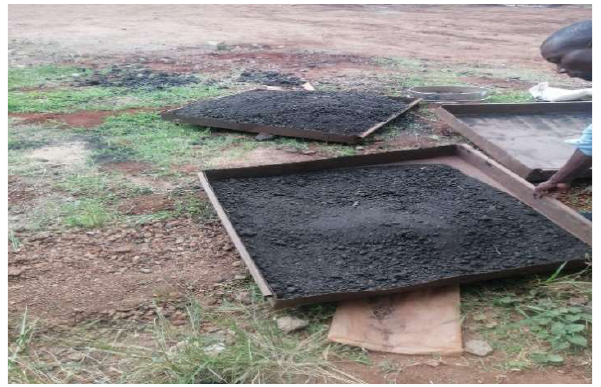
Figure 1. BCS material sample. Table 1. Engineering properties of BCS.